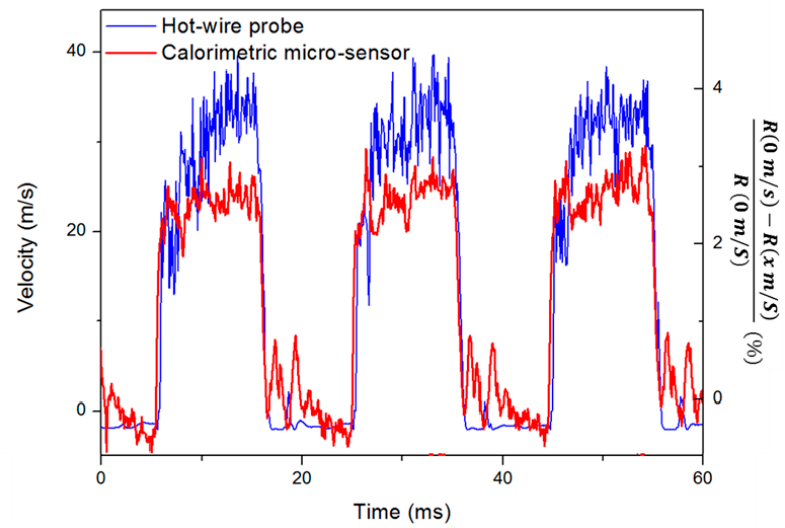
Figure 3. Micro-sensor and hot-wire responses for pulsed blowing at 50 Hz actuation frequency.